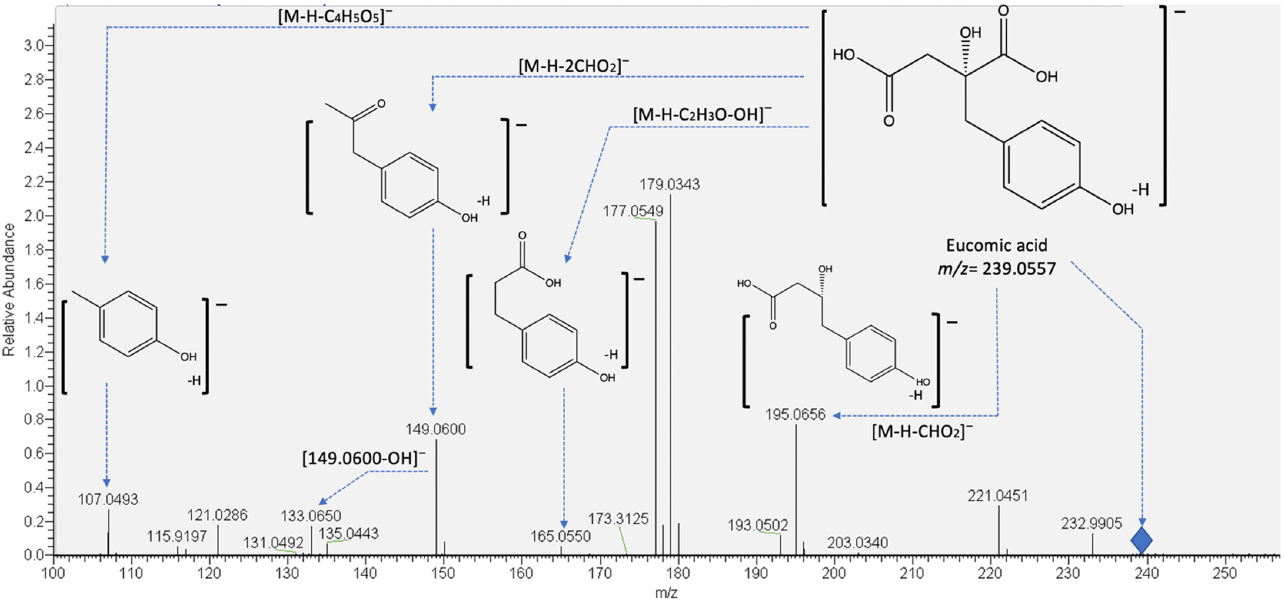
Figure 3. Proposed fragmentation pattern of eucomic acid (peaks 9 and 10). Table 2. Metabolites identified in cooked and crude young stems of A. tetragonus by UHPLC-PDA- HESI-Orbitrap-MS/MS.